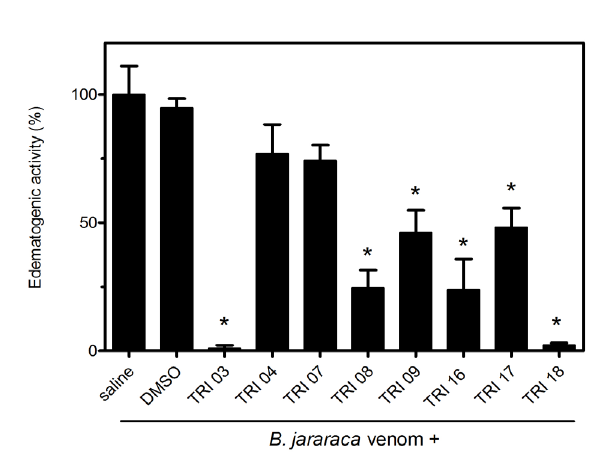
FIGURE 4 - Effect of derivatives on edema caused by B. jararaca